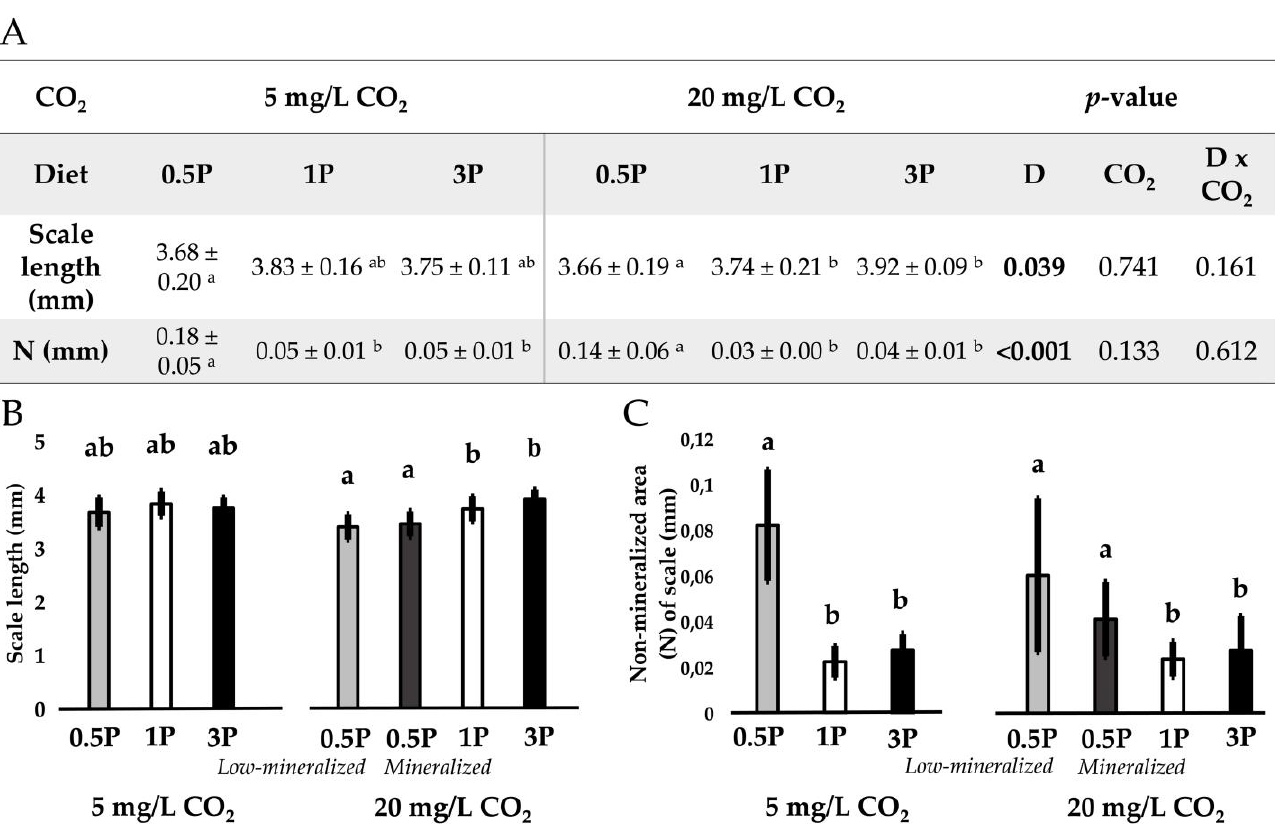
Figure 5. Scale measurements. Values for scale length and non-mineralized area (N) of scale in animals fed different levels of total phosphorus (P) 0.5P (6.3 g/kg), 1P (9.0 g/kg), and 3P (26.8 g/kg) and reared in conditions with no CO 2 injected (5 mg/L) or with injected CO 2 (20 mg/L) ( A ). The statistically significant differences among groups (within a row) are indicated by different lowercase superscript letters. If none of the letters are the same, differences are significant. The significant values ( p ) for CO 2 , diet (D), and their interaction are indicated. ( A , B ) show average values for scale length and N which include measurement of 0.5P animals reared in 20 mg/L CO 2 which showed either low-mineralized or mineralized bone phenotype. While the scale length of 0.5P/20CO 2 mineralized animals is comparable to 0.5P/20CO 2 low-mineralized ( B ), 0.5P/20CO 2 mineralized animals show a trend to reduce the extension of N in the anterior part of scales ( C ). Significant differences in measurements are denoted by a different